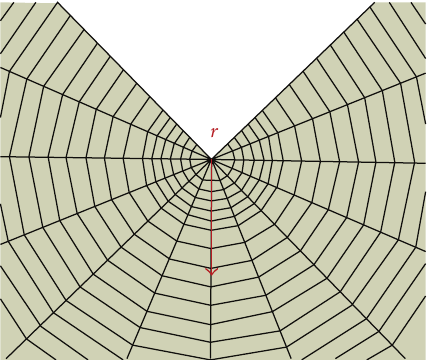
Figure 8: Assumed virtual crack extension.